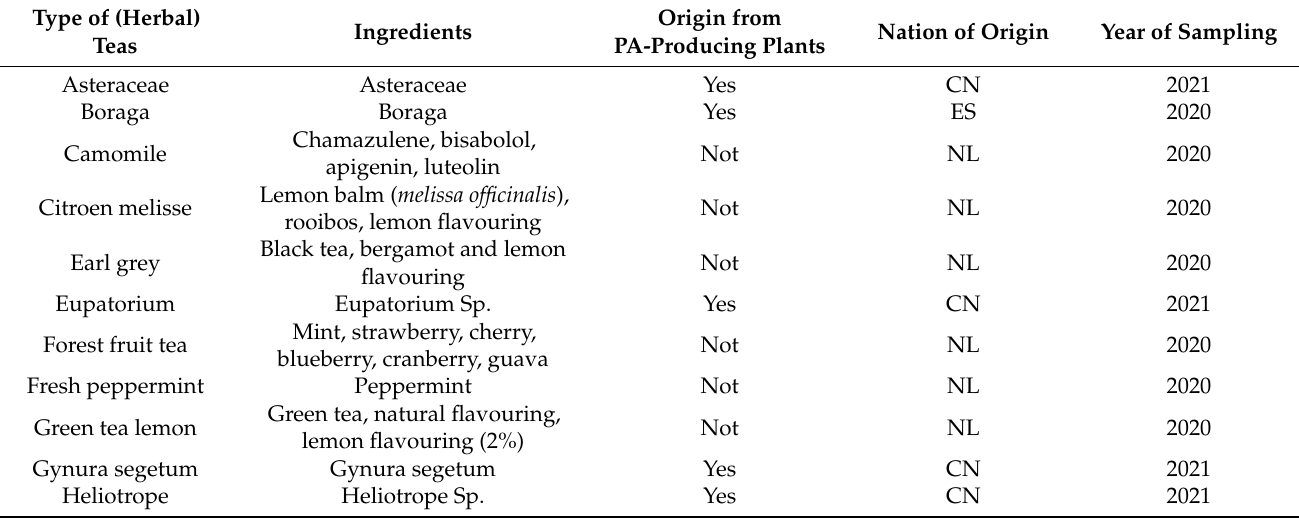
Table 1. Ingredients and PA-producing property of the studied (herbal) teas.